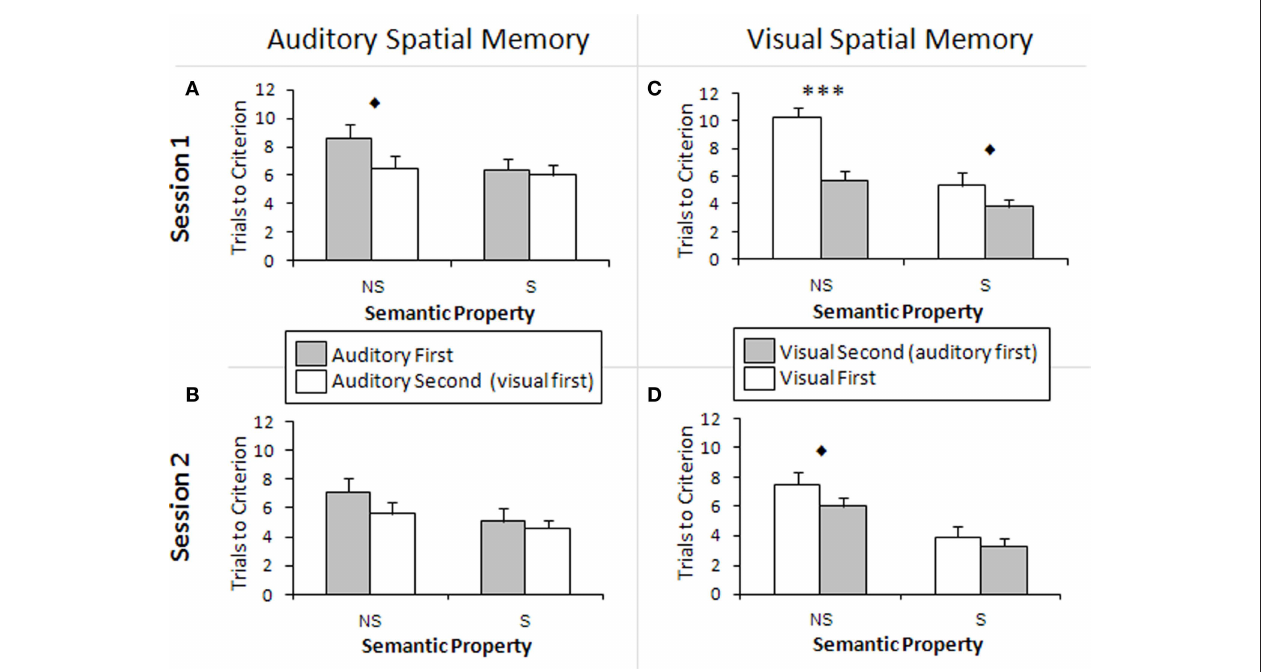
the visual task second, i.e., after the auditory task. There is a significant difference in Session 1 performance on non-semantic stimuli between the two groups. There is also a difference in performance related to semantic stimuli in Session 1 and non-semantic stimuli in Session 2, and this approached significance. A cross-modal learning effect is apparent: the participants who performed the visual task second performed better on the visual task. NS, non-semantically meaningful stimuli; S, semantically meaningful stimuli; *** p < 0.001, ♦ p < 0.1. The bars show the